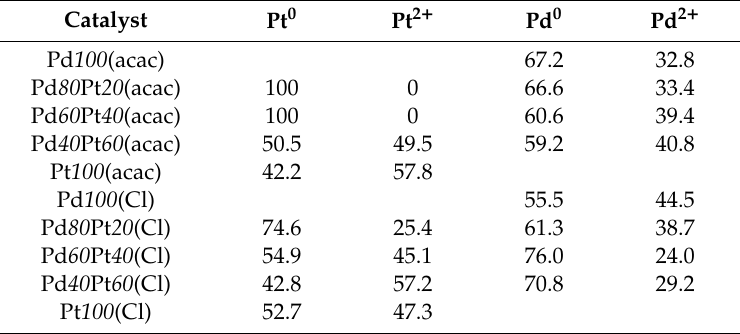
Figure 7. XPS profiles in the Pt 4f region (right) and the Pd 3d region (left) of the Pd–Pt(ex-Cl) catalysts. Thin black lines—deconvoluted spectra, red lines—fitted overall profiles, thick black lines—envelope spectra. Table 2. Relative distribution of zerovalent and electrodeficient species on the surfaces of two series (acac and Cl) of Pd–Pt / carbon catalysts. For catalyst designation, see Section 3.1.